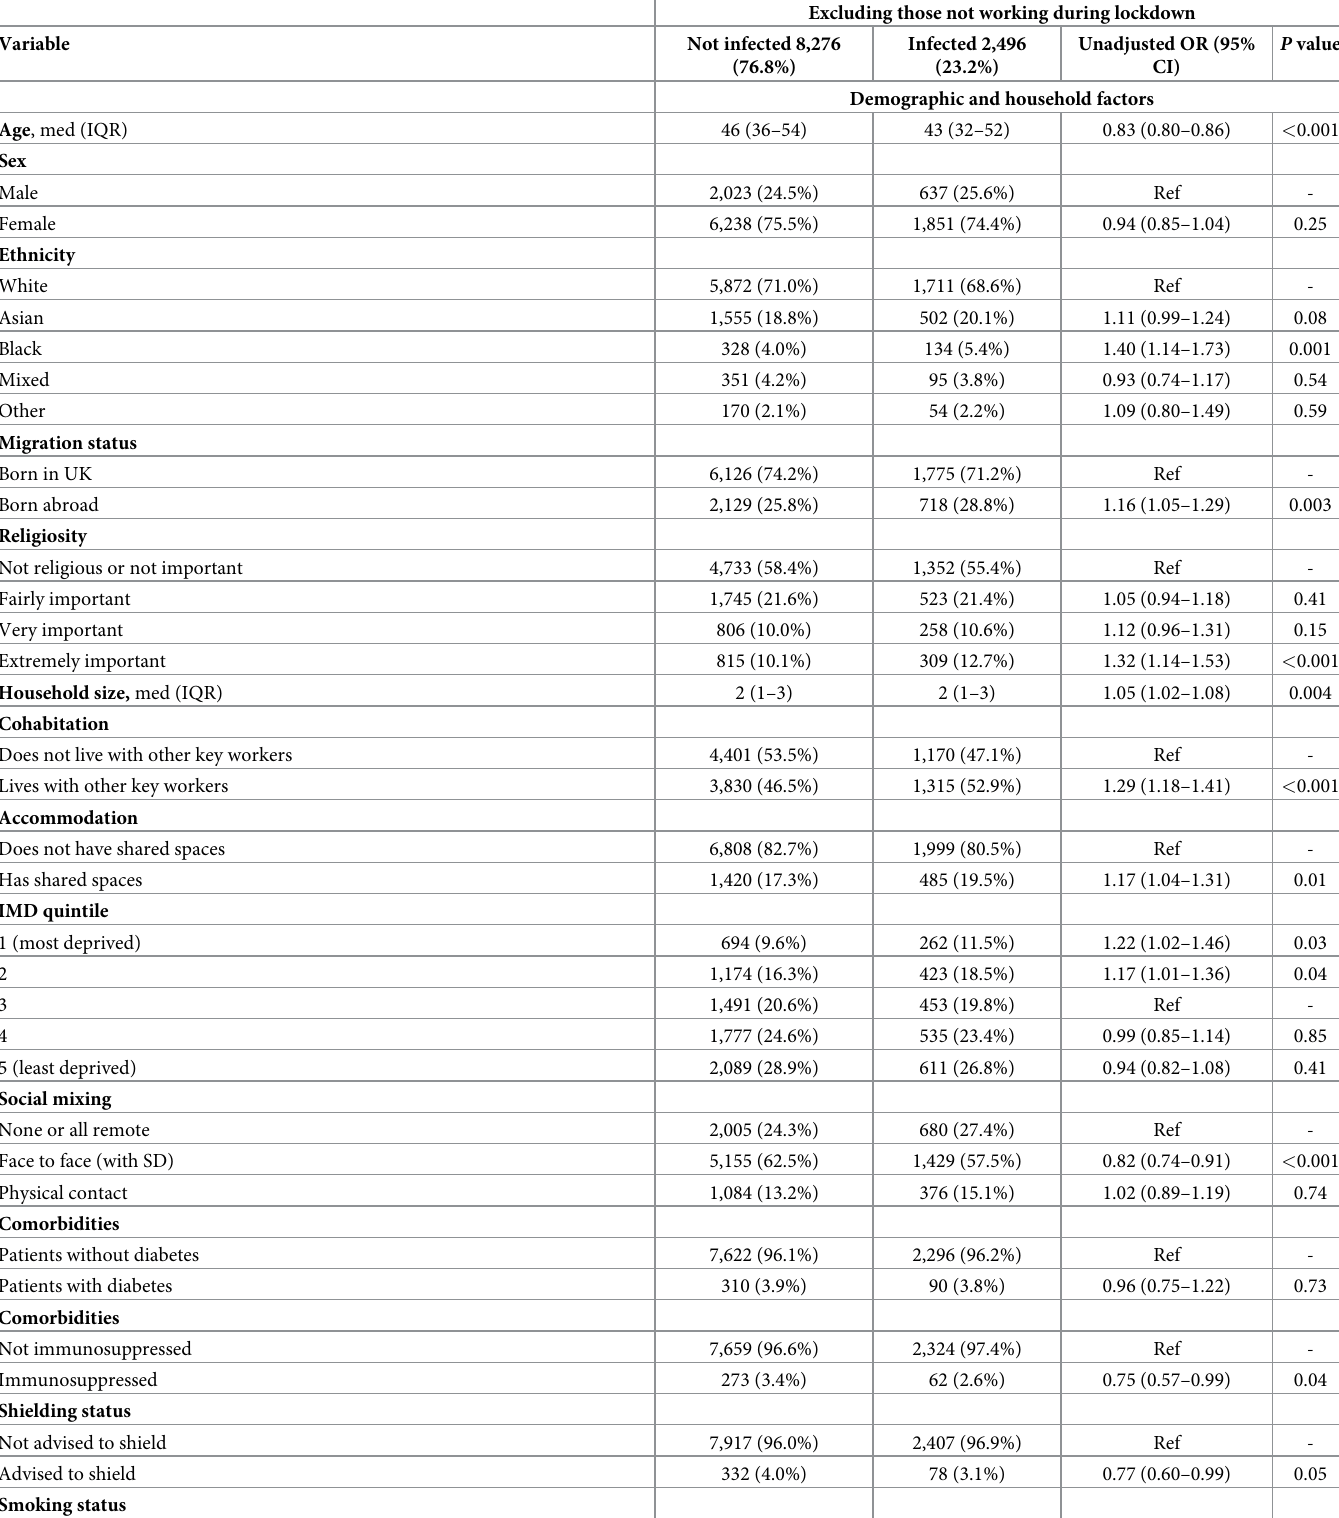
Table 2. Description of the cohort working during lockdown stratified by SARS-CoV-2 infection status with unadjusted odds ratios for the association of covariates with